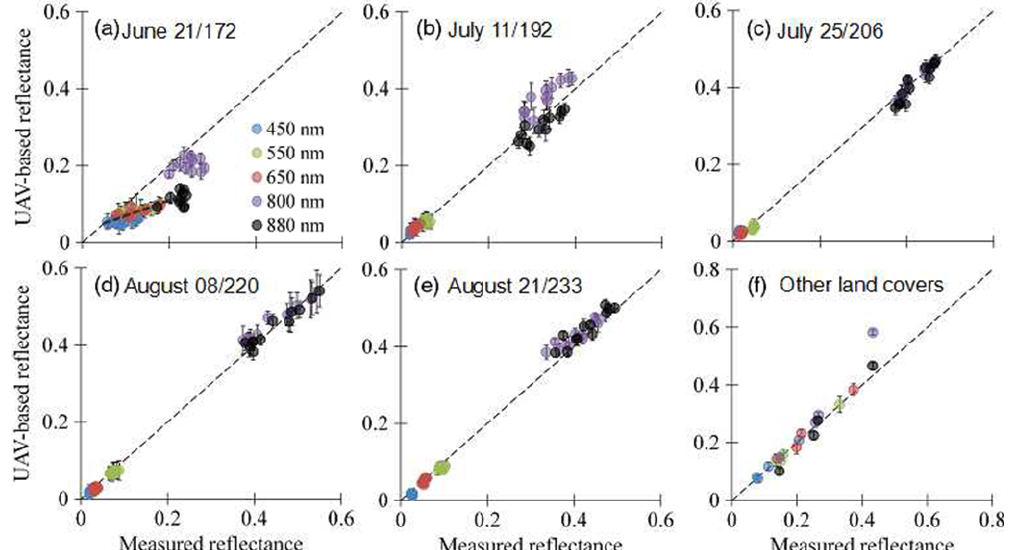
Figure A1. Validation of radiometrically calibrated UAV-based re- flectance by measurements of group point reflectance set up in paddy fields across the whole growing season (a–e) and in other land covers obtained on day of year (DOY) 172, 192, and 220 in- cluding bright cement, dark asphalt, bare soil, and tilled soil (f) . Dashed line in each subplot shows 1 : 1 ratio. Recalibration for UAV-based reflectance in red waveband was conducted on 21 June (DOY 172), shown in subplot a (coarse dashed